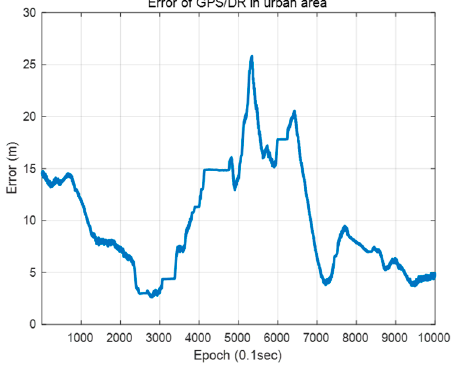
Figure 26. Error of the GPS/DR in urban area.